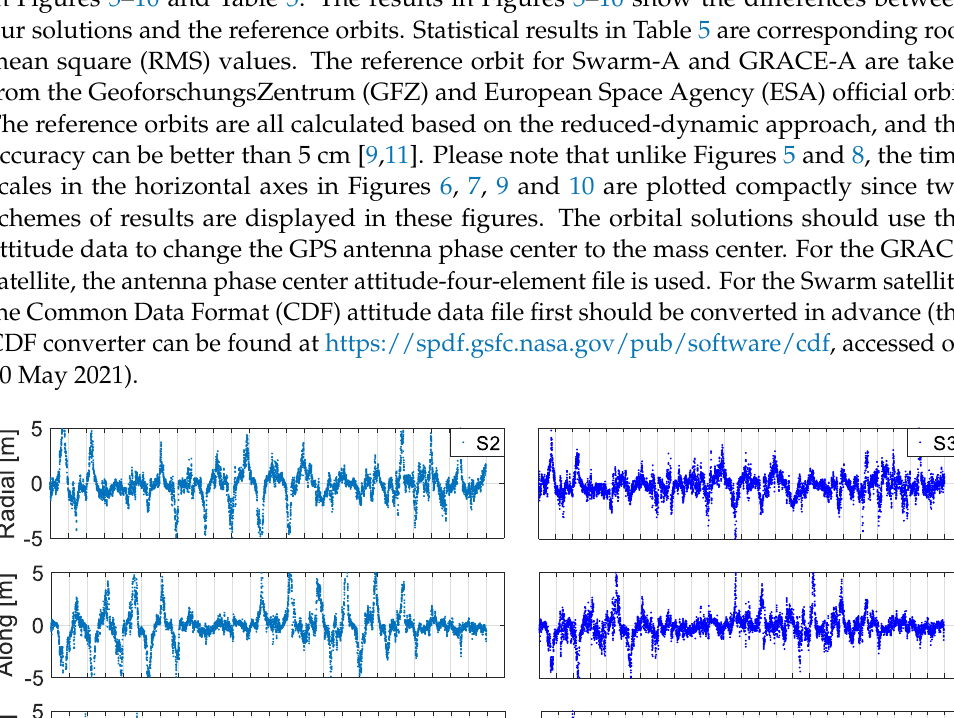
Figure 6. Swarm-A real-time POD results of Schemes 2 ( left ) and 3 ( right ).